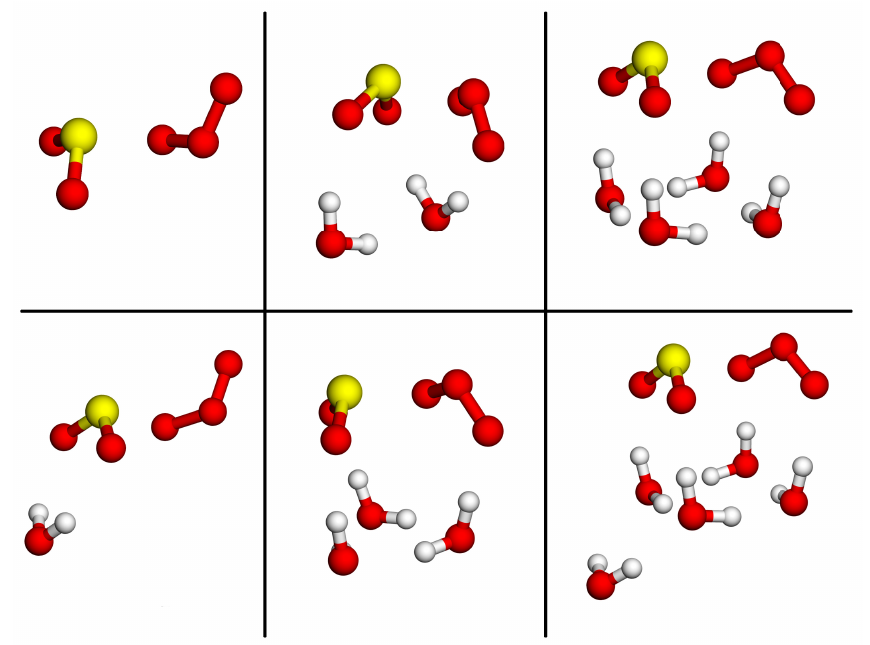
( H 2 O ) n , n = 0–5. For all water containing structures, a strong 3